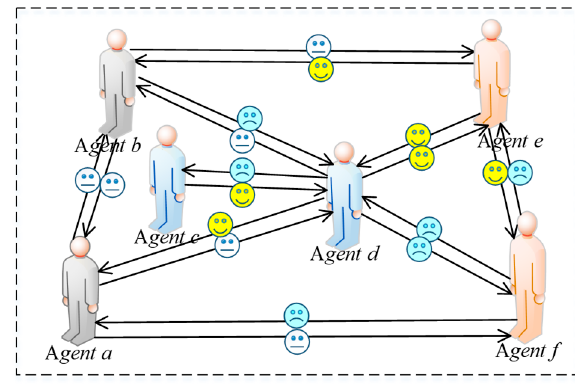
Figure 6. Revenue change diagram.